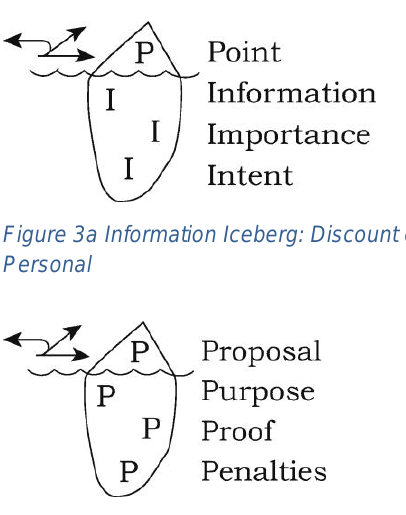
Figure 3b Information Iceberg: Discount of Meaning - Work